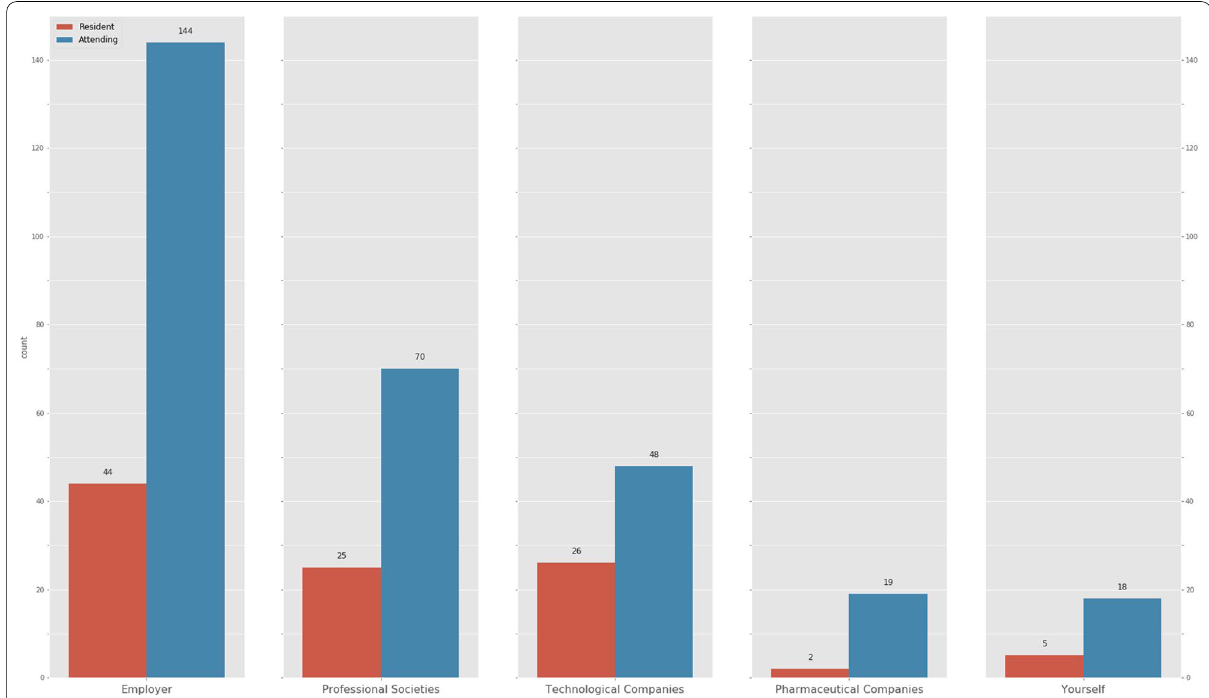
Fig. 2 Distribution of responses about who should financially cover the costs of AI training. Responses are divided into residents (red) and attending physicians (blue). The y ‑axis shows the number of answers for each group